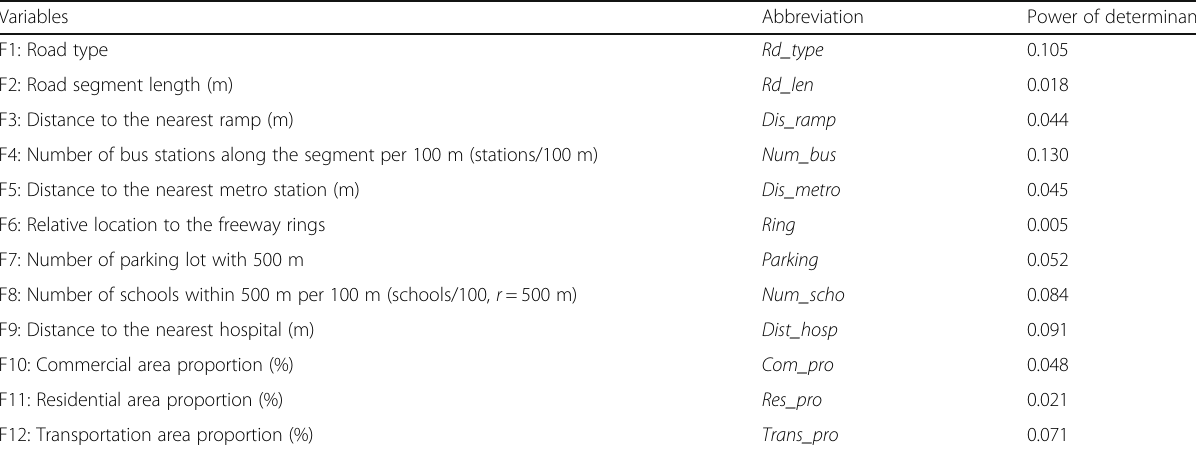
Table 2 Built environmental factors for traffic flow and PD [24]